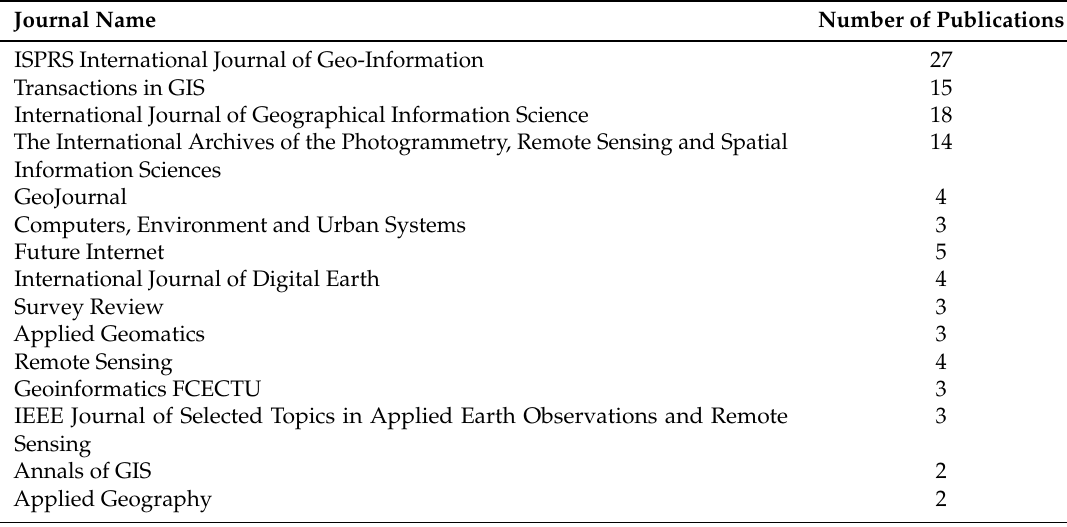
Table 4. Top fifteen journals focusing on OpenStreetMap (OSM).